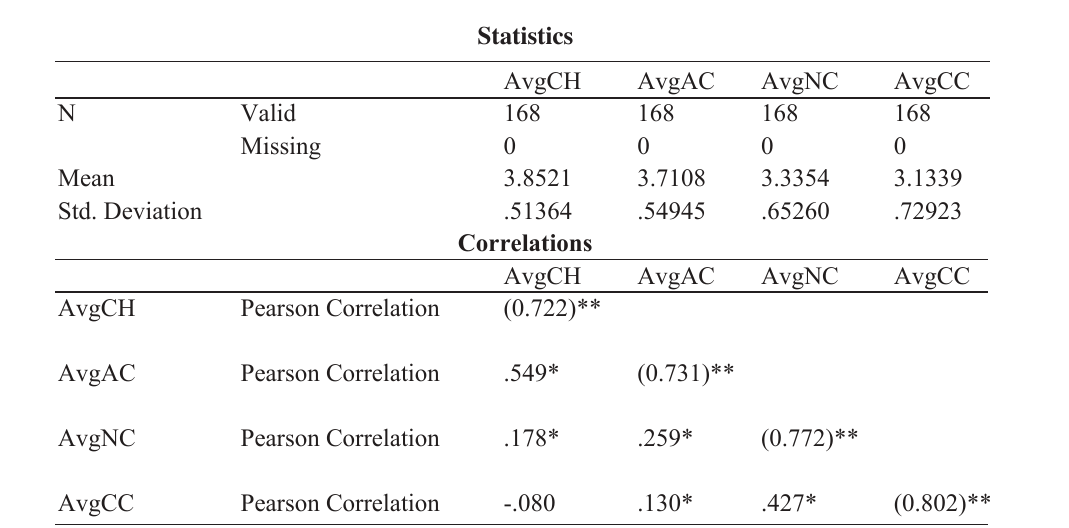
Table 3: Mean, Standard Deviation and correlations of the